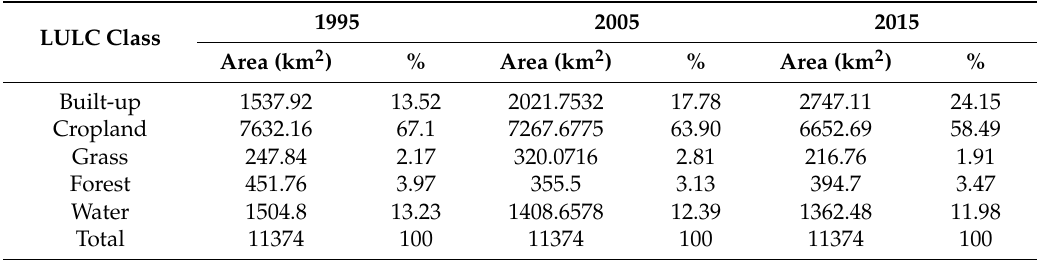
Table 2. LULC classification